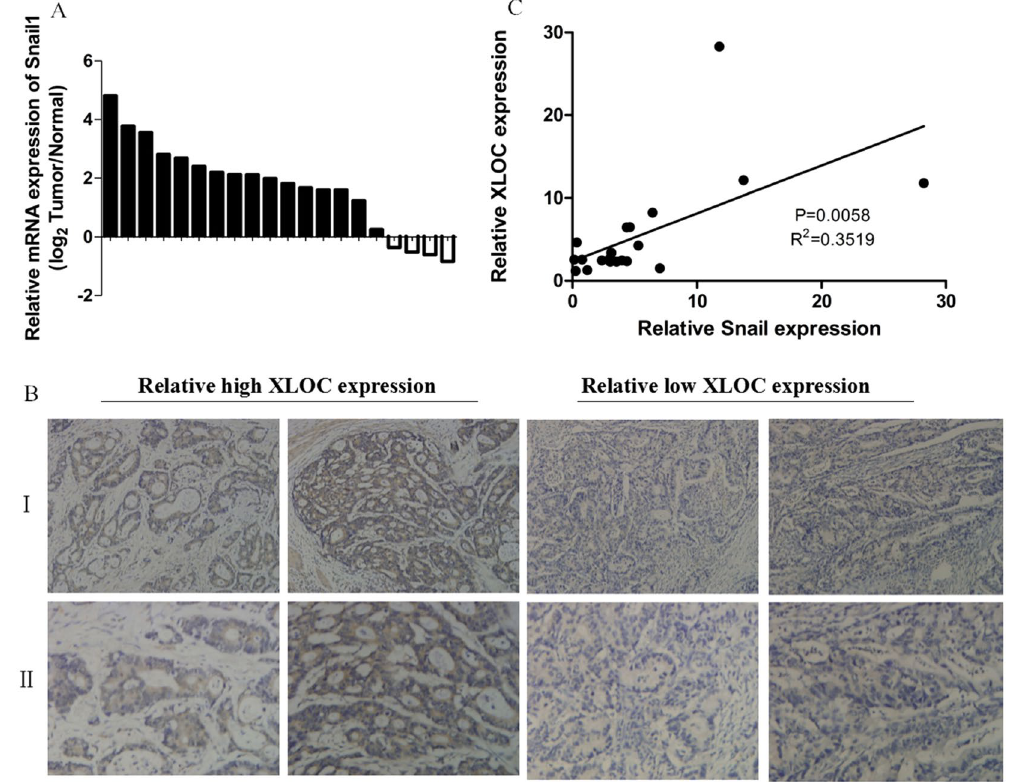
Figure 4. Positive correlation between XLOC_010235 and Snail1 expression. ( A ) Snail1 mRNA levels in gastric cancer tissues were analyzed by qRT-PCR. ( B ) Immunostaining of Snail1 protein in gastric cancer tissue samples. Left panel: immunostaining of Snail1 was positive in gastric cancer tissues with relatively high XLOC expression. Right panel: immunostaining of Snail1 was negative in gastric cancer tissues with relatively low XLOC expression. Original magnifications of × 200 (I) and × 400 (II) are shown. ( C ) Analysis of the relationship between XLOC expression and Snail1 mRNA level in 20 gastric cancer